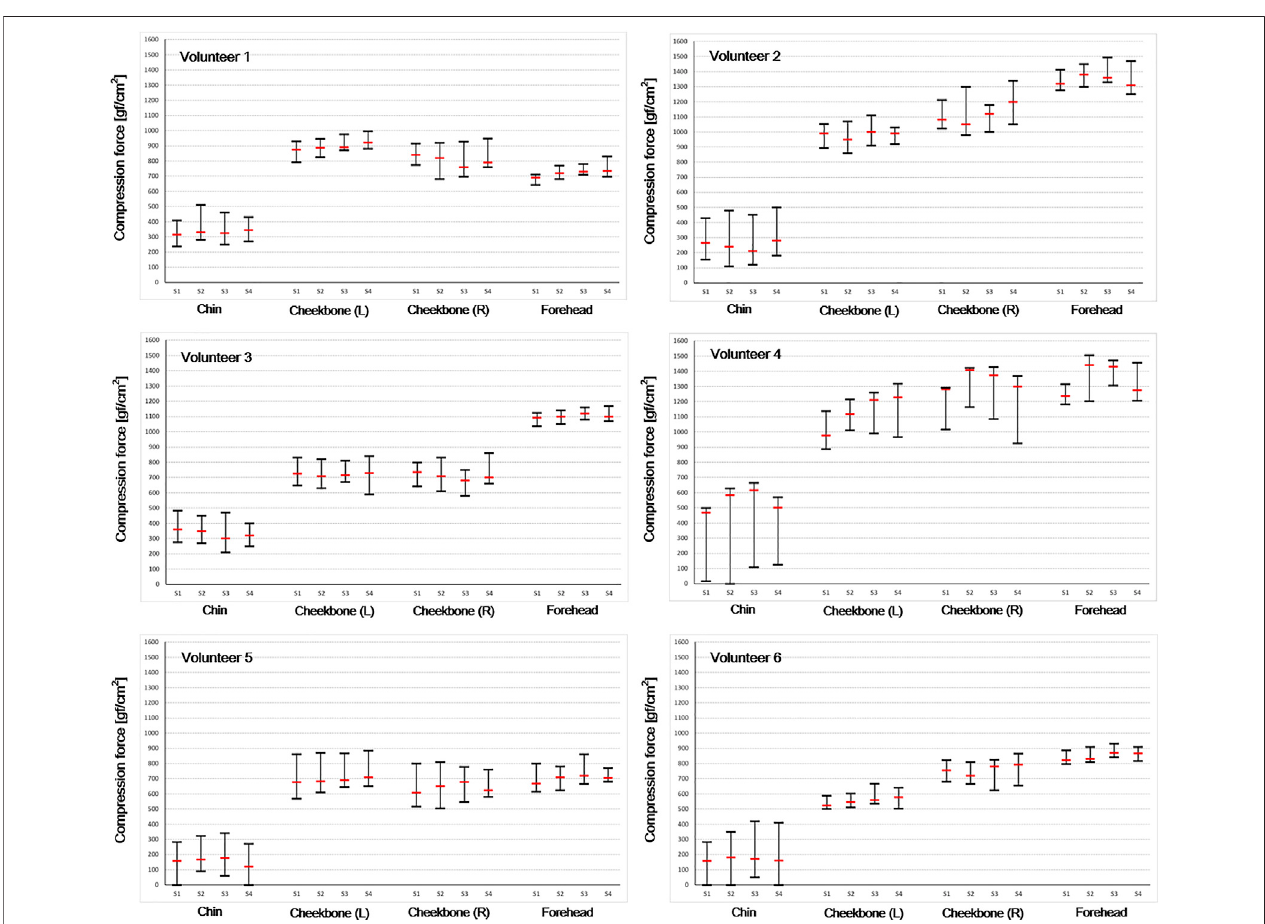
FIGURE 8 | Compression force variation range and mean value were acquired to evaluate thermoplastic mask setup reproducibility. Each volunteer took four sessions (S1 – S4 means each session number).